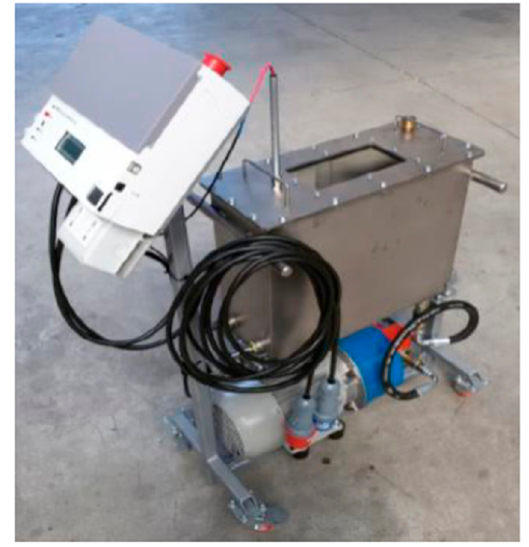
Figure 1. Image of hydraulic test bench realized to age